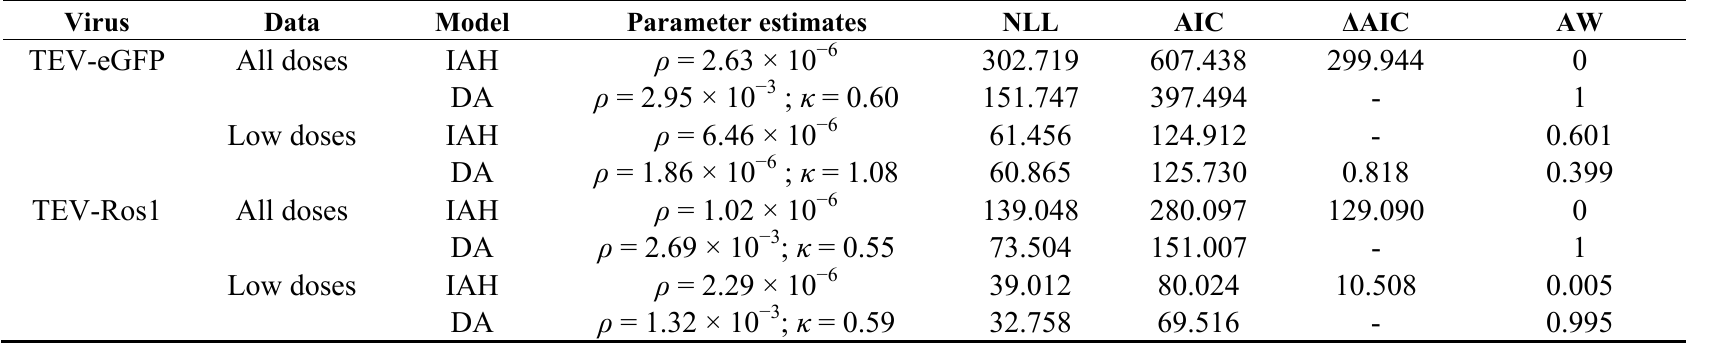
Table 1. Infection models for dose-foci relationship. Model fitting and selection results are given for the dose-foci relationship (Figure 2c) of TEV-eGFP and TEV-Ros1. Data indicates whether the full data set was used (all doses), or only the partial data set was used (low doses), which comprises only the lowest three doses. Model indicates whether the independent action hypothesis (IAH) or dependent action (DA) model was fitted. Estimated model parameters are the probability of infection per virion ( ρ ) and, for the DA model, a constant that determines the strength of dose-dependent effects on ρ ( κ ). For a detailed description of the models see Section 3.4. NLL is negative likelihood, a measure of model fit. AIC is Akaike Information Criterion, Δ AIC is the difference in AIC between the best-fitting model and other models, and AW